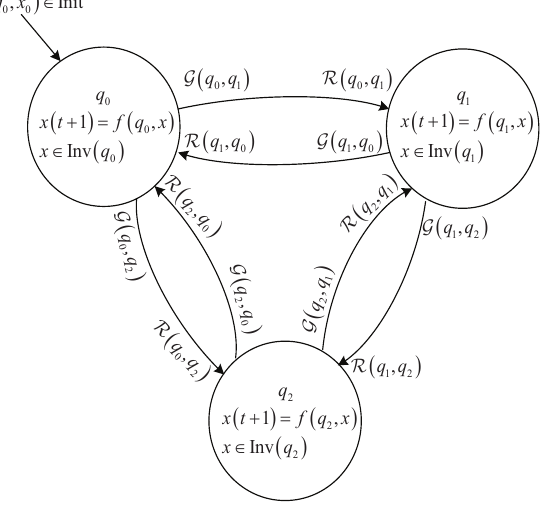
Figure 1. Digraph expression of hybrid